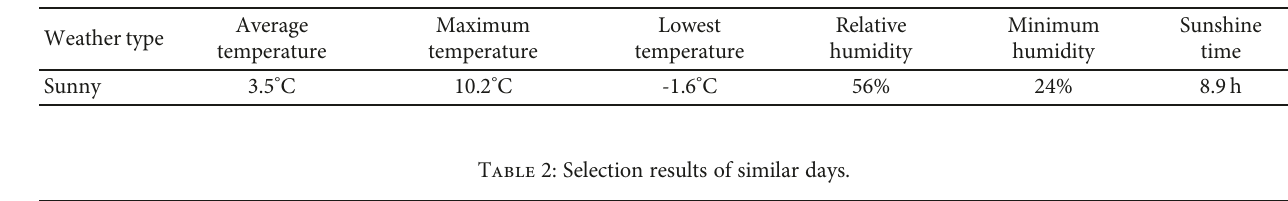
Table 1: Meteorological parameters of forecasting day.